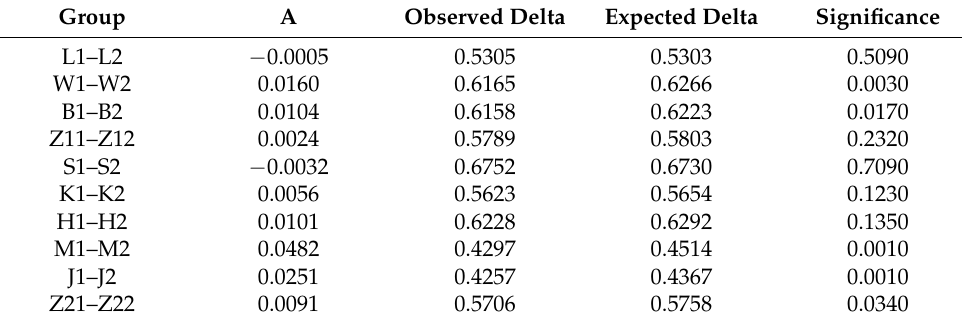
cance < 0.05 represents that intergroup differences are